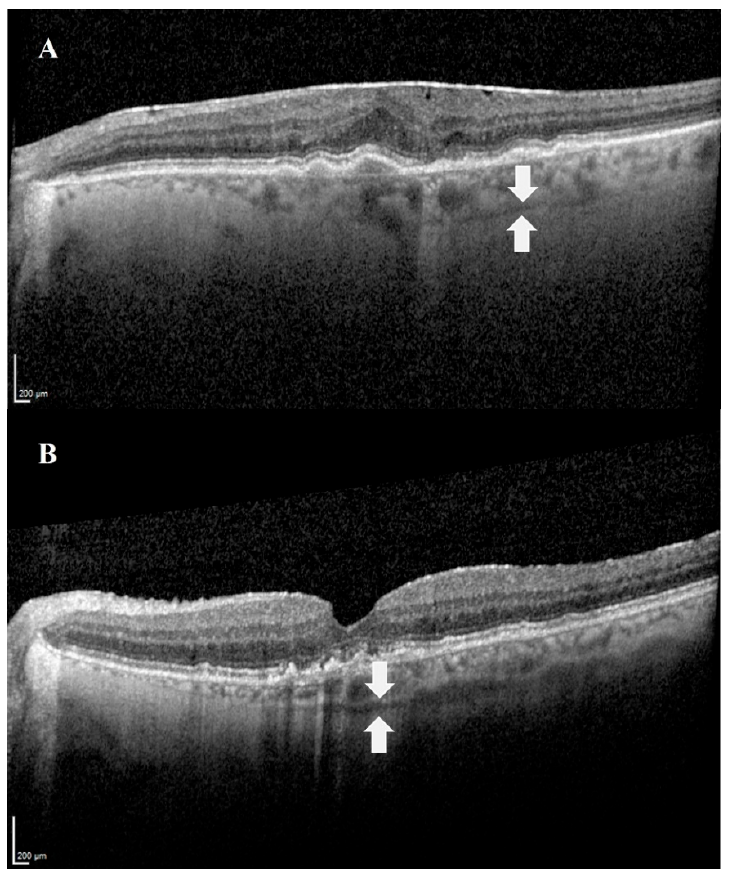
Figure 2. Images demonstrating the SCS in OCT. The suprachoroidal space can be visualized as a hyporeflective band (white arrows), between the choroid and the sclera. ( A ) An image of the left eye of an 80-year-old female patient with age-related macular degeneration. ( B ) An image of the left eye of a 74-year-old male patient with age-related macular degeneration.